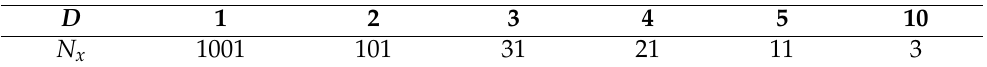
Table 1. Number of equispaced points, N x , used per input direction as a function of input dimen- sion, D